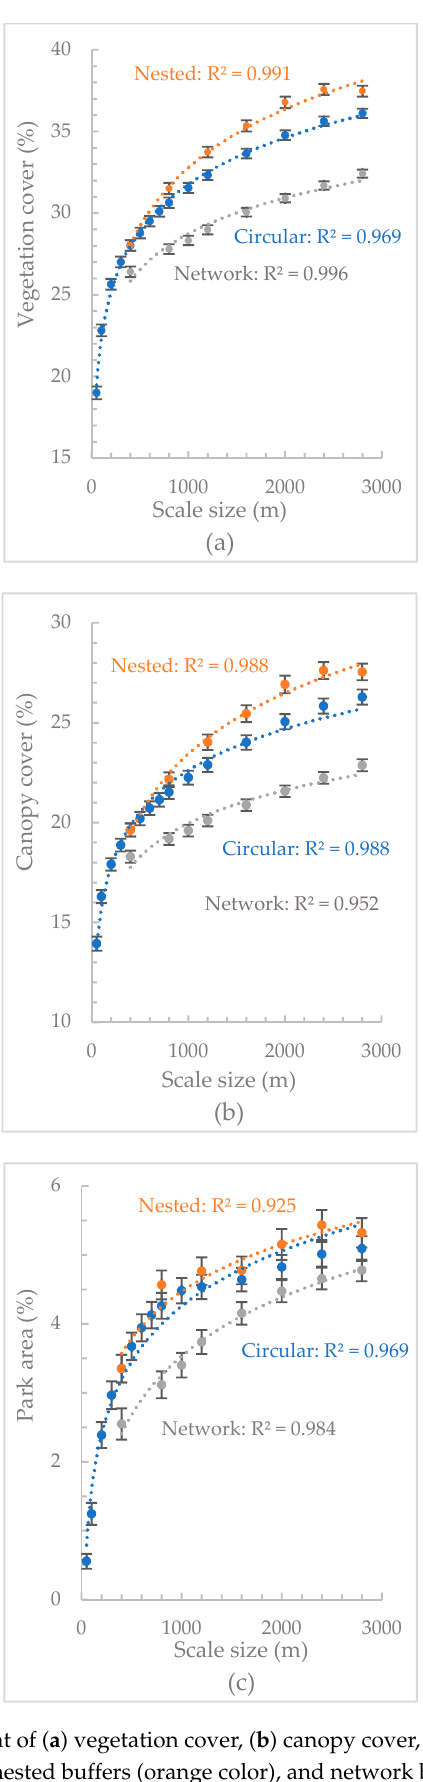
Figure 3. The average amount of ( a ) vegetation cover, ( b ) canopy cover, and ( c ) park area at different circular buffers (blue color), nested buffers (orange color), and network buffers (grey color).